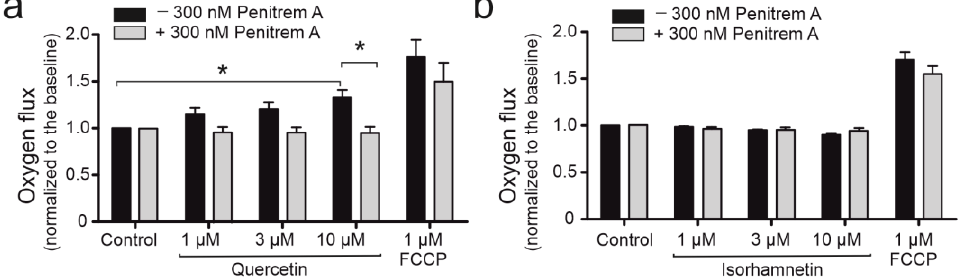
Figure 3. The effect of quercetin and isorhamnetin on oxygen consumption rate in whole HBE cell model. The bars represent the effect of quercetin at different concentrations (1, 3, 10 µM) ( a ), and isorhamnetin (1, 3, 10 µM) ( b ), on HBE cell oxygen consumption rate, measured with high-resolution respirometry. The effect of the tested compounds (black bars) was compared to oxygen consumption rate measured in the presence of 300 nM penitrem A (gray bars). Full uncoupling was induced by 1 µM FCCP. The results are represented by means ± SD, n = 3. Statistical significance was determined at p < 0.05 (*) by one-way ANOVA.